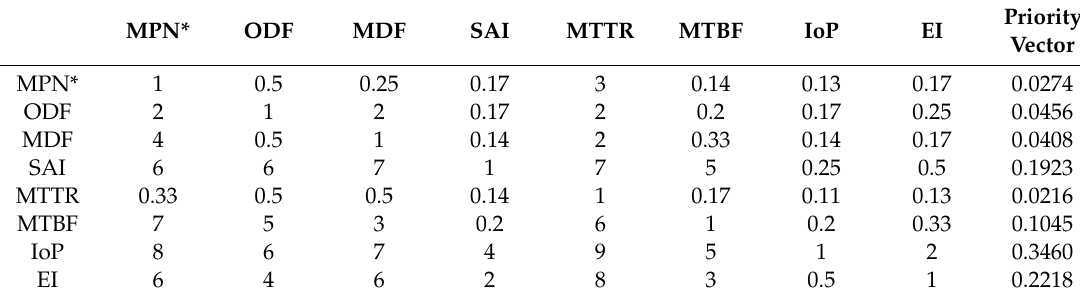
Table 10. Judgment Matrix with the Scores for Each Considered Criterion.